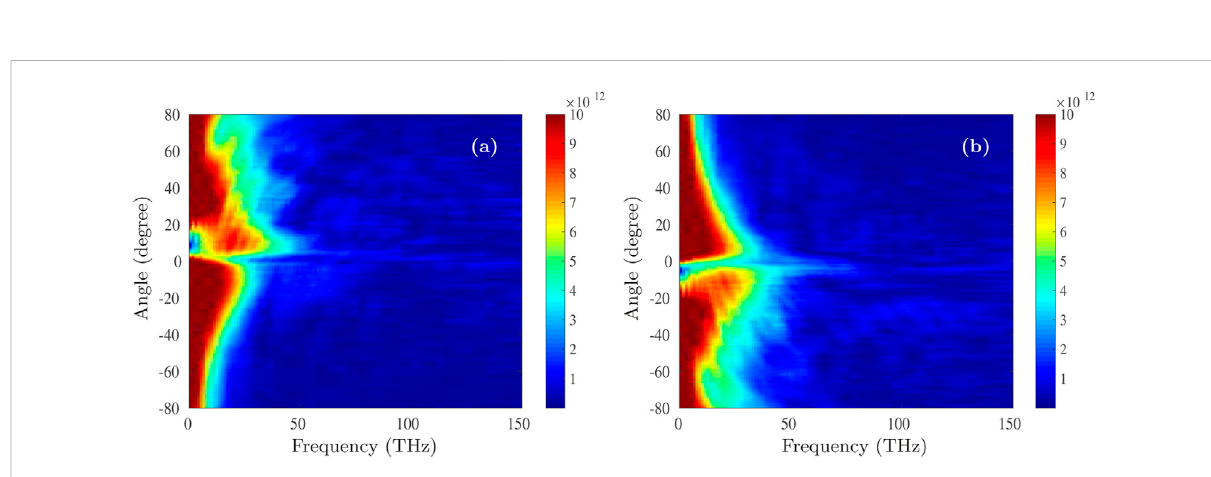
FIGURE 6 The angular-spectra distribution of the THz radiation for the y = 4.8 λ 0 (A) and y = − 4.8 λ 0 (B)